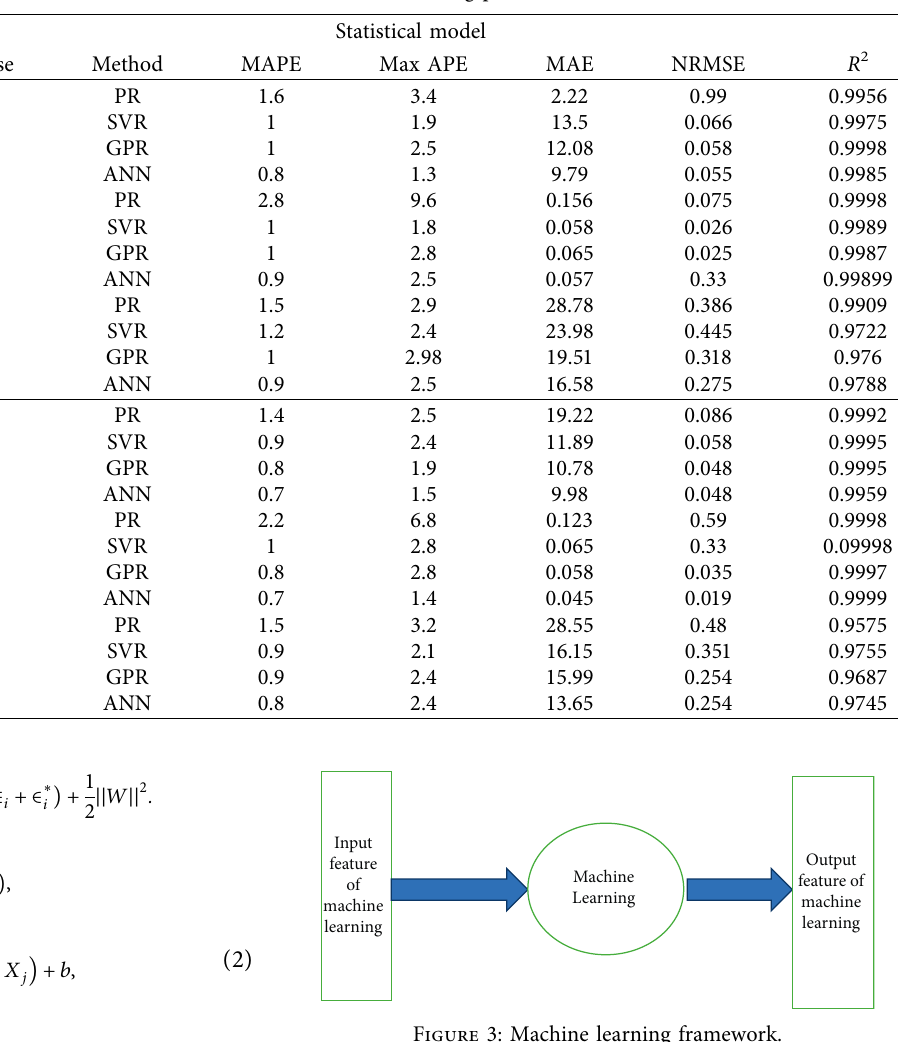
Figure 2: Structure of decision tree. Table 2: Performance of different machine learning process.